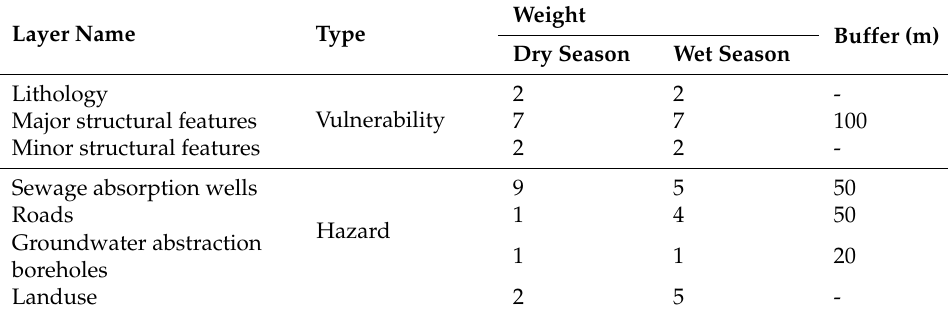
Table 2. The inventory of layers and their assigned weight for the risk